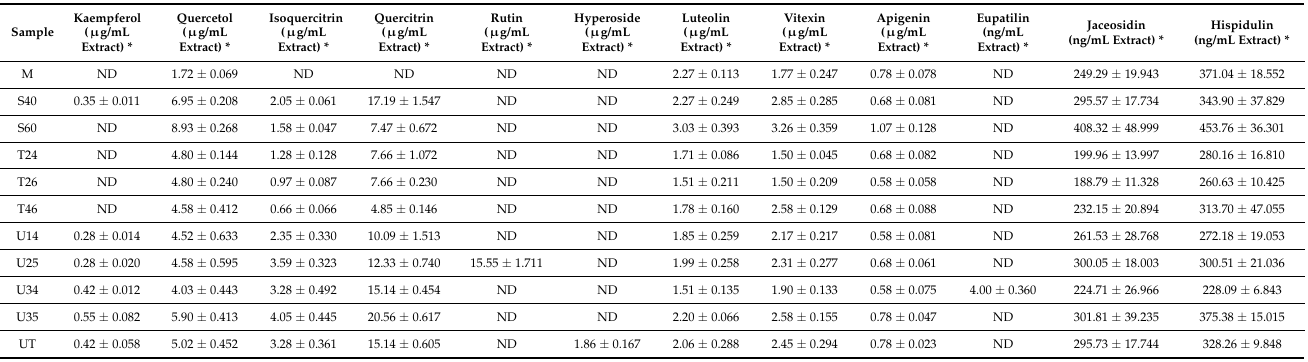
Table 5. Flavonoid compounds in the selected extracts.